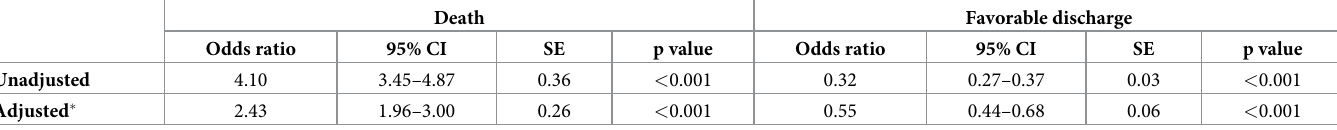
Table 2. Mixed-effects logistic regression fit to in-hospital death and favorable discharge, showing odds ratios for ICH patients with comorbid COVID-19 com- pared with controls.